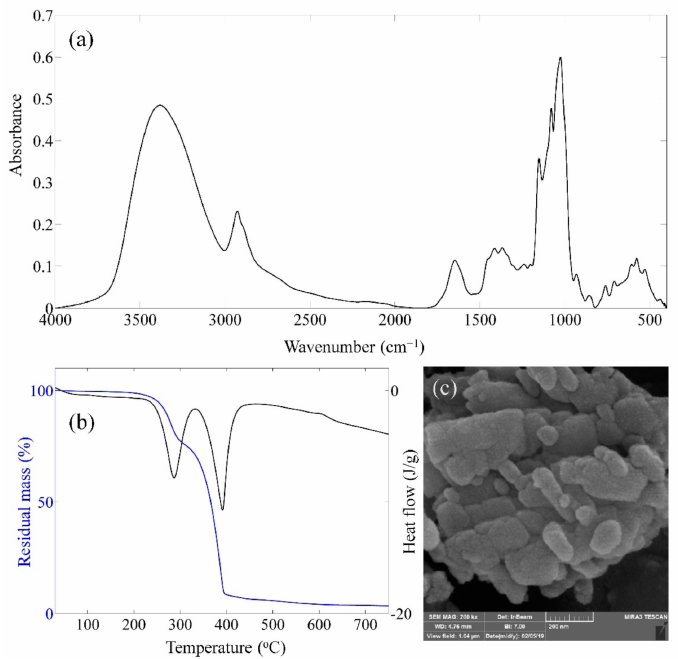
Figure 1. ( a ) FTIR spectrum, ( b ) TGA (blue)/DSC (black) diagram, and ( c ) SEM images of produced